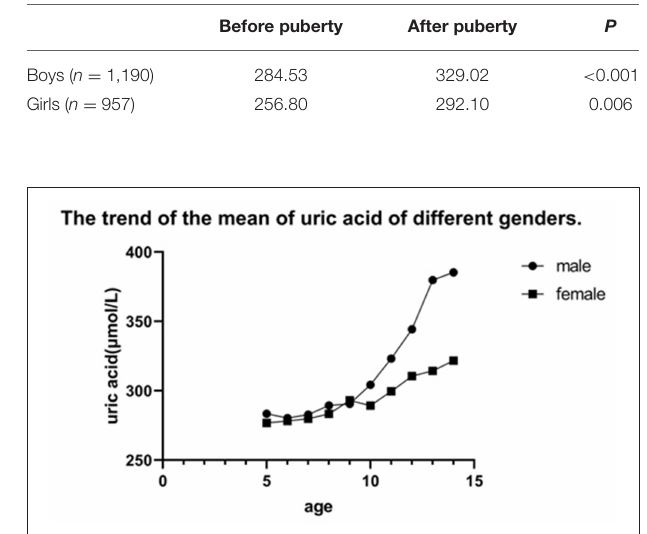
TABLE 2 | The change of uric acid level before and after puberty ( µ mol/L).